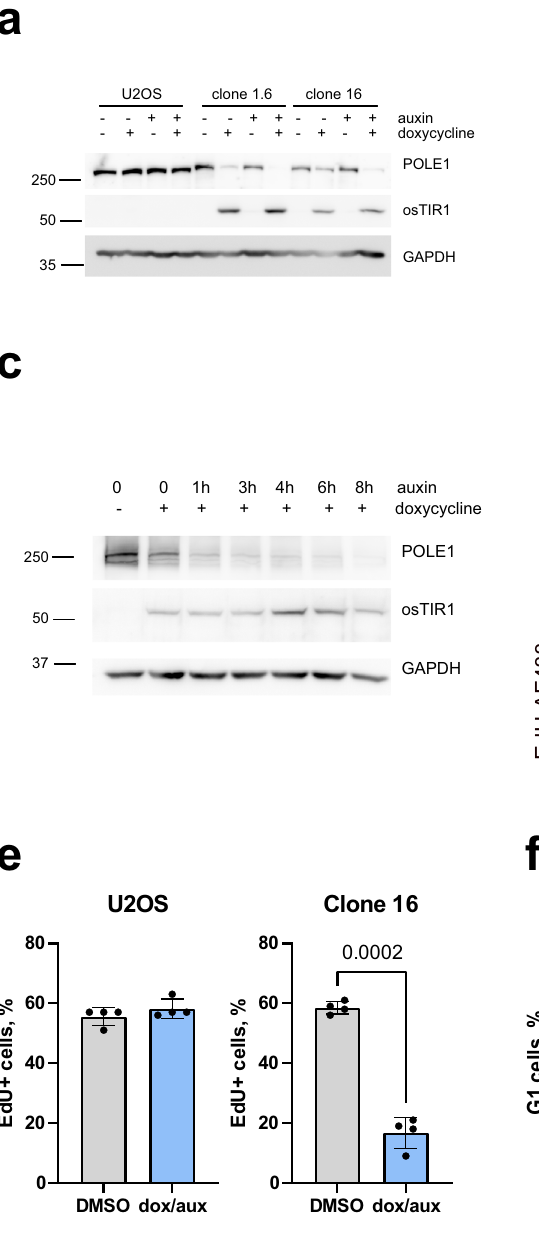
Fig. 1 | Creating and characterizing a cell line expressing mAID-tagged polE1. a Wild-type U2OS, homozygous mAID-KI clones 16 and 1.6 were treated for 24h withdoxycycline,auxin,or both, asindicated, westernblotsof totalcelllysates are shown. b Equal numbers or wild-type U2OS, or homozygous mAID-KI clones 16